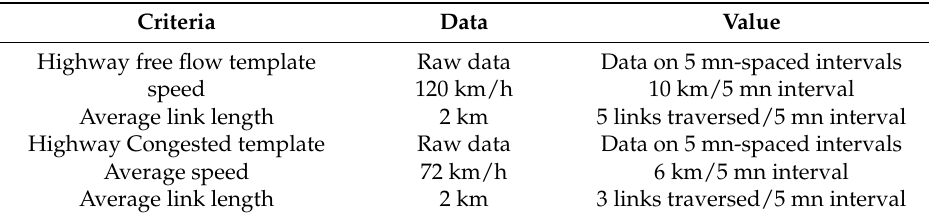
Table 1. Values for highway links.